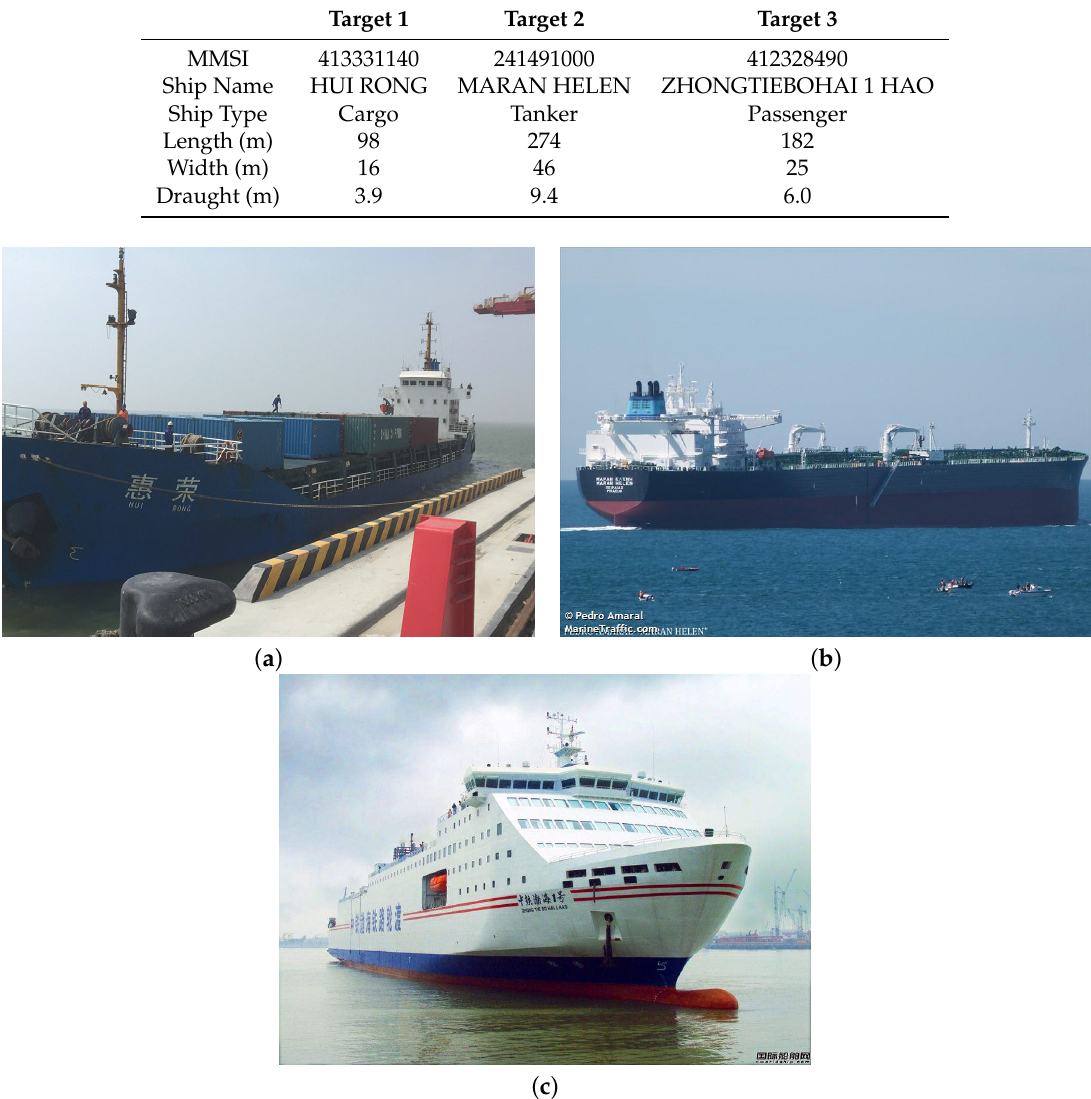
Figure 4. Photos of three targets considered in this paper. ( a ) Target 1—HUI RONG, the photo is from the website: www.yantaiport.com.cn. ( b ) Target 2—MARAN HELEN, the photo is